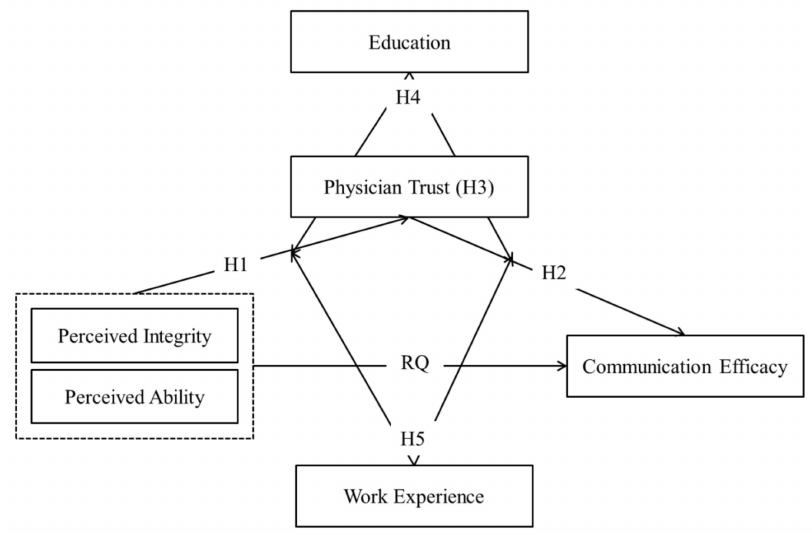
Figure 1. The conceptual